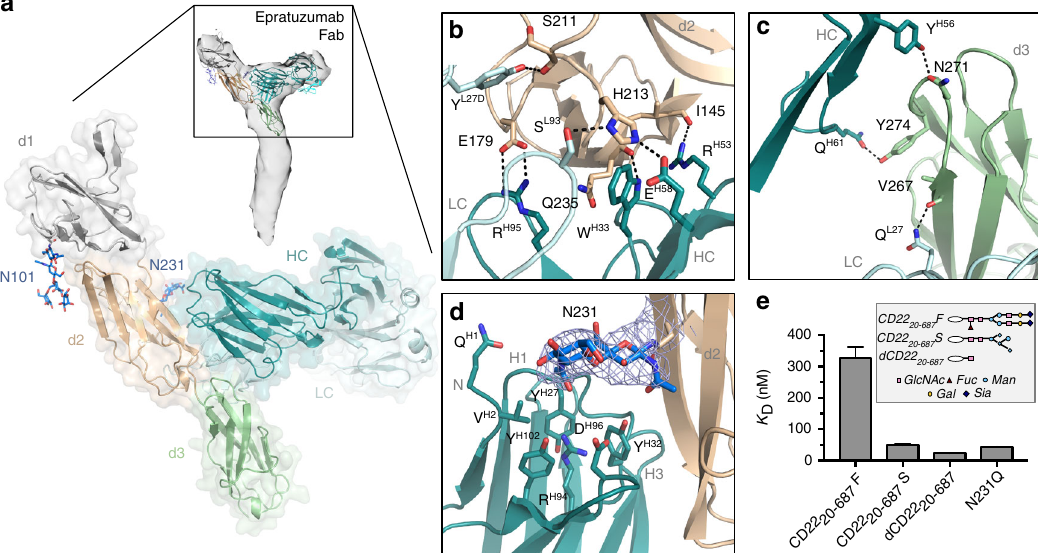
Fig. 5 Antigenic surface of CD22 recognized by therapeutic antibody epratuzumab. a Epratuzumab heavy chain ( dark teal ) and light chain ( light cyan ) bind the CD22 d2 ( wheat )/d3 ( light green ) interface as revealed by X-ray crystallography ( bottom ) and negative-stain EM ( top ). b Epratuzumab interactions with CD22 d2 are mediated by HCDRs, LCDR1, and LCDR3. c Epratuzumab interactions with CD22 d3. d The N231 glycan is part of the epratuzumab epitope. Composite omit electron density map for the N231 glycan GlcNAc 2 residues ( sticks ) is shown as a blue mesh (1.0 σ contour level). Epratuzumab residues shown as sticks are buried by the N231 glycan. e Kinetics of epratuzumab binding to CD22 20 – 687 F, CD22 20 – 687 S, dCD22 20 – 687 , and CD22 20 – 687 F N231Q. Epratuzumab binds with higher af fi nity to CD22 with smaller N-linked glycans. The inset depicts examples of glycoforms likely to be present on CD22 from recombinant expression in HEK293F and HEK293S cells, and treated by EndoH. Error bars represent the standard error of the mean (SEM) derived from three independent BLI